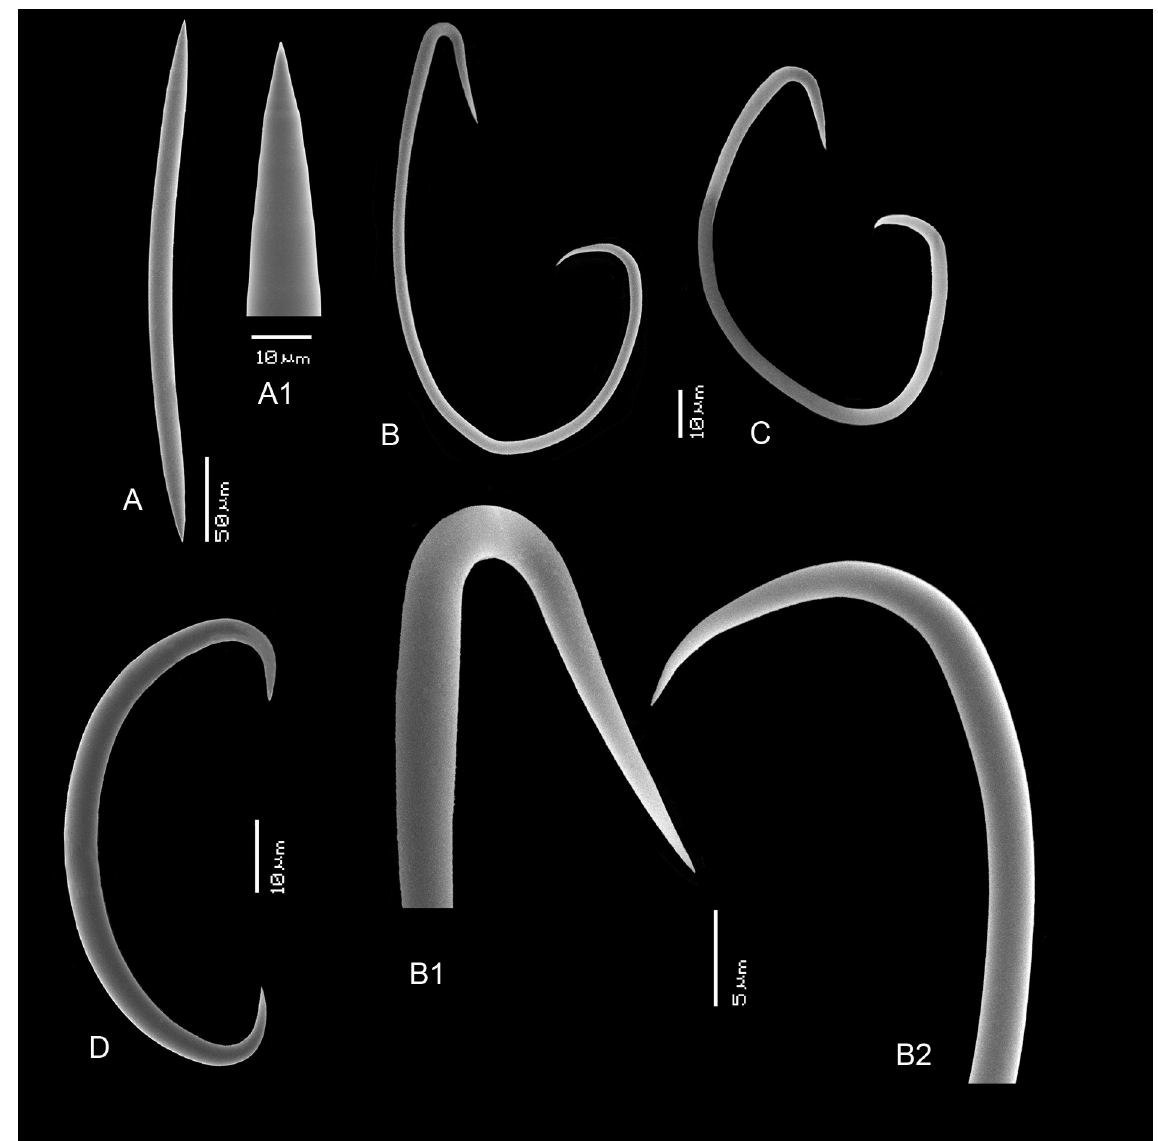
Fig. 18. Haliclona ( Flagellia ) edaphus (De Laubenfels, 1930) from California, SEM images of the spicules made from a fragment of the holotype (USNM 21444). A . Oxea. A apices. B–C . Flagellosigmas. B . Detail of long ending of flagellosigma. B 1 flagellosigma. D .